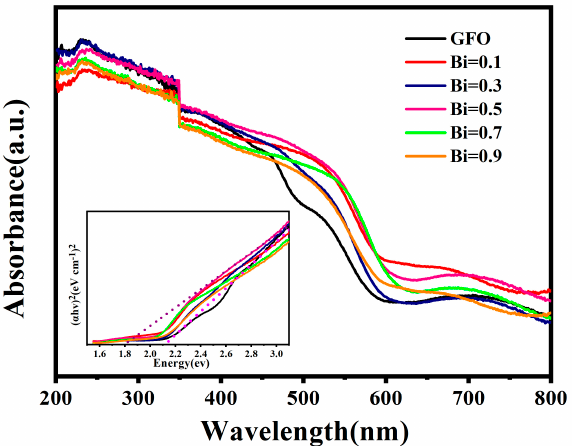
Figure 5. UV-vis absorption spectra of Gd 1-x Bi x FeO 3 nanoparticles; the inset shows the calculation of the band gaps.